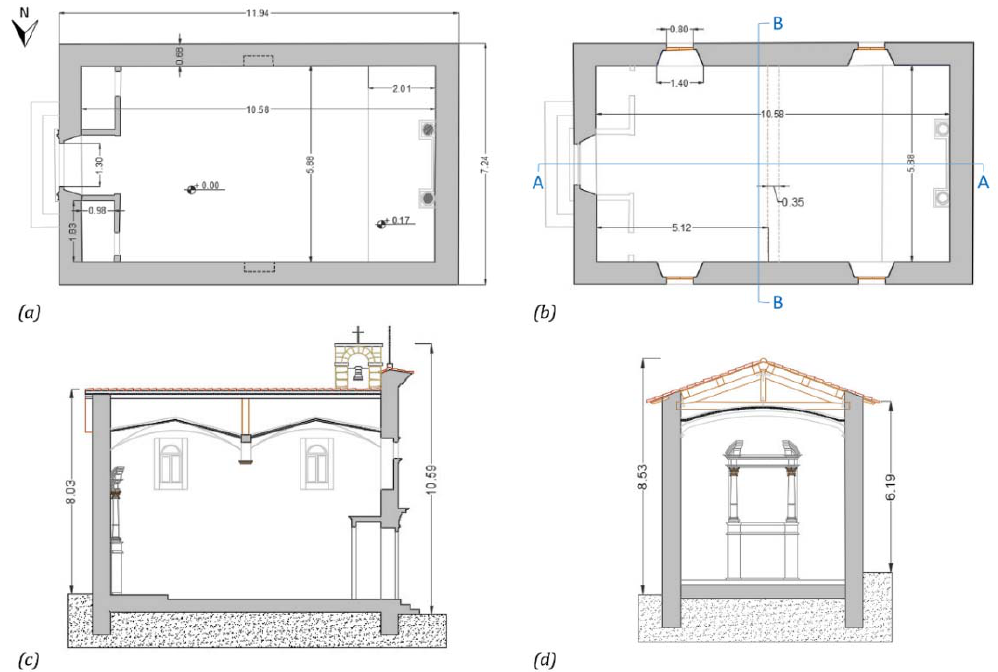
Figure 2. Geometric configuration (dimensions in meters) of the Santissimo Crocifisso Church in Pretare (Arquata del Tronto, AP): ( a ) plan at +1.00 m, ( b ) plan at +5.20 m, ( c ) section A-A, and ( d ) section B-B.